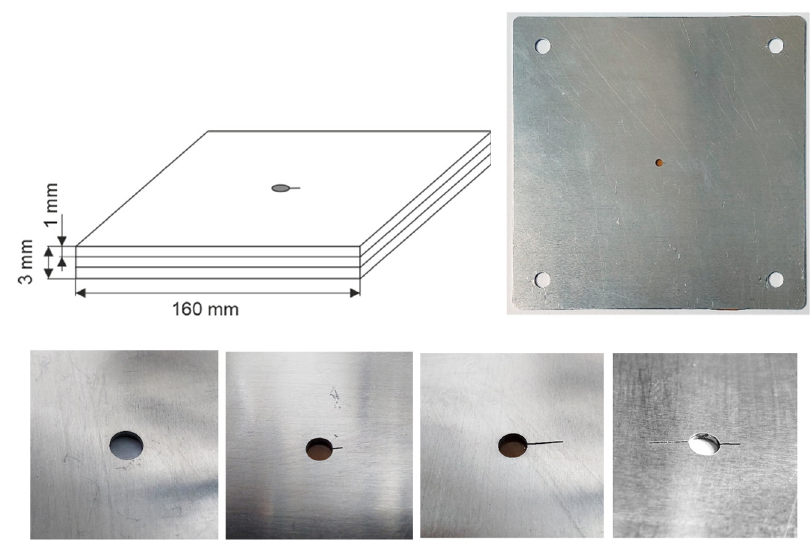
Figure 12. The aluminum test specimens used in the experiments.